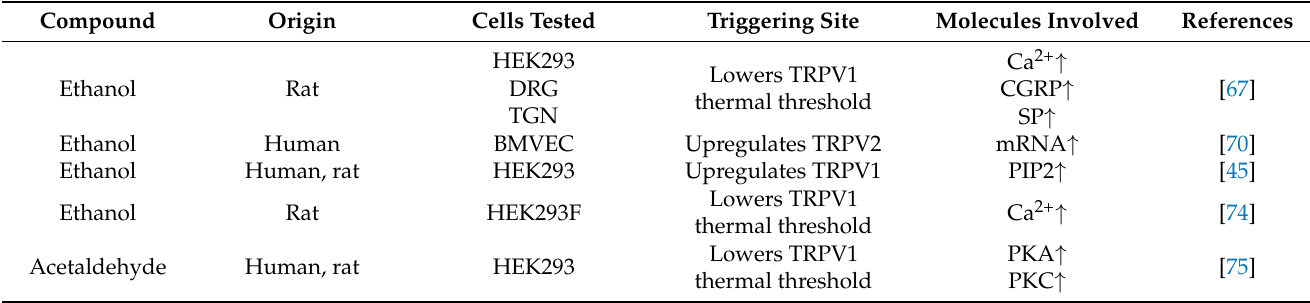
Table 2. Research on the effects of ethanol and its derivatives in